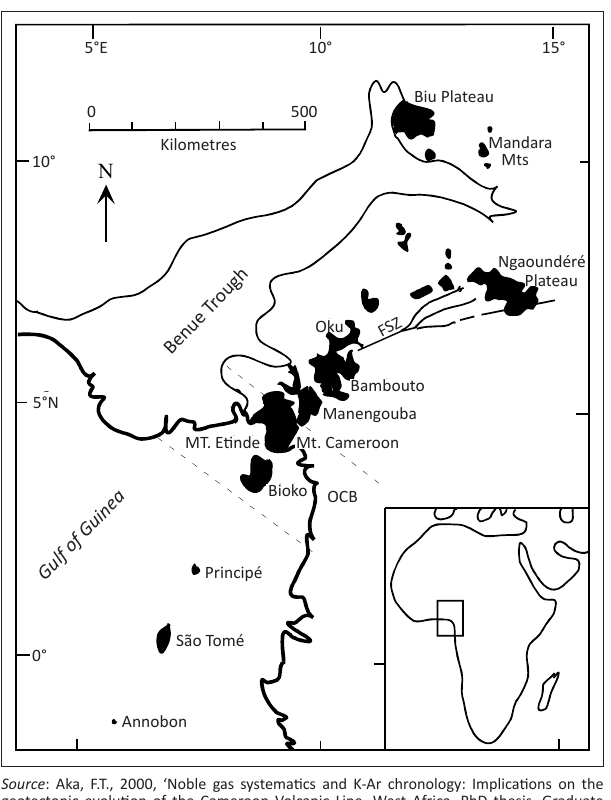
FIGURE 3: Map showing the volcanic centres (in black) of the Cameroon Volcanic Line